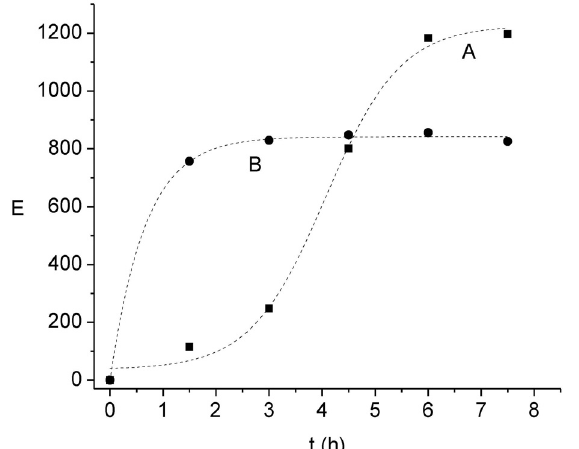
Figure 5. Influence of the composition of the acceptor solution on the enrichment factor. Donor phase: 6.6 × 10 − 6 mol L − 1 Ni(II), 0.01 mol L − 1 MES, pH 6.6; membrane phase: 0.012 mol L − 1 Kelex 100; acceptor phase: 0.01 mol L − 1 HCOOH, pH = 1 ( A ), and 0.1 mol L − 1 HCOOH, pH = 2 ( B ).